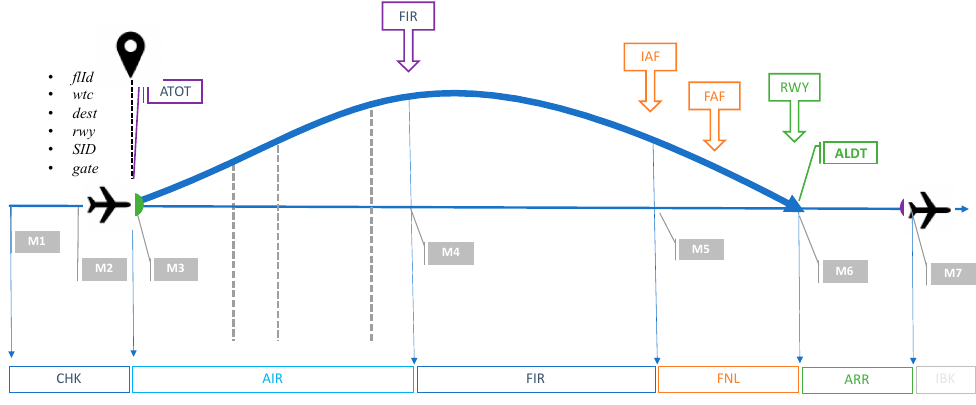
Figure 3. The inbound phase of the flight on the milestone approach and its nomenclature.